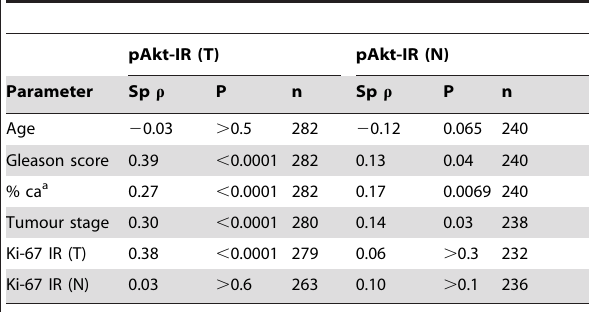
Table 1. Correlation coefficients for pAkt-IR scores with clinical parameters and with the proliferation marker Ki-67.